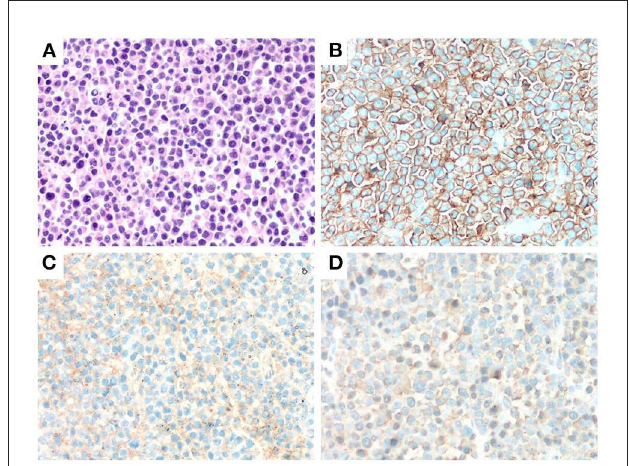
FIGURE1 Immunohitsochemical (IHC) analysis of the morphology of left frontal mass in case 2. A markedly proliferation of abnormal plasma cells was observed by H&E staining ( × 400) (A) . Abnormal plasma cells were positive for CD38 and CD138 (IHC staining × 400) (B, C) . Abnormal plasma cells expressed λ (IHC staining × 400) (D)